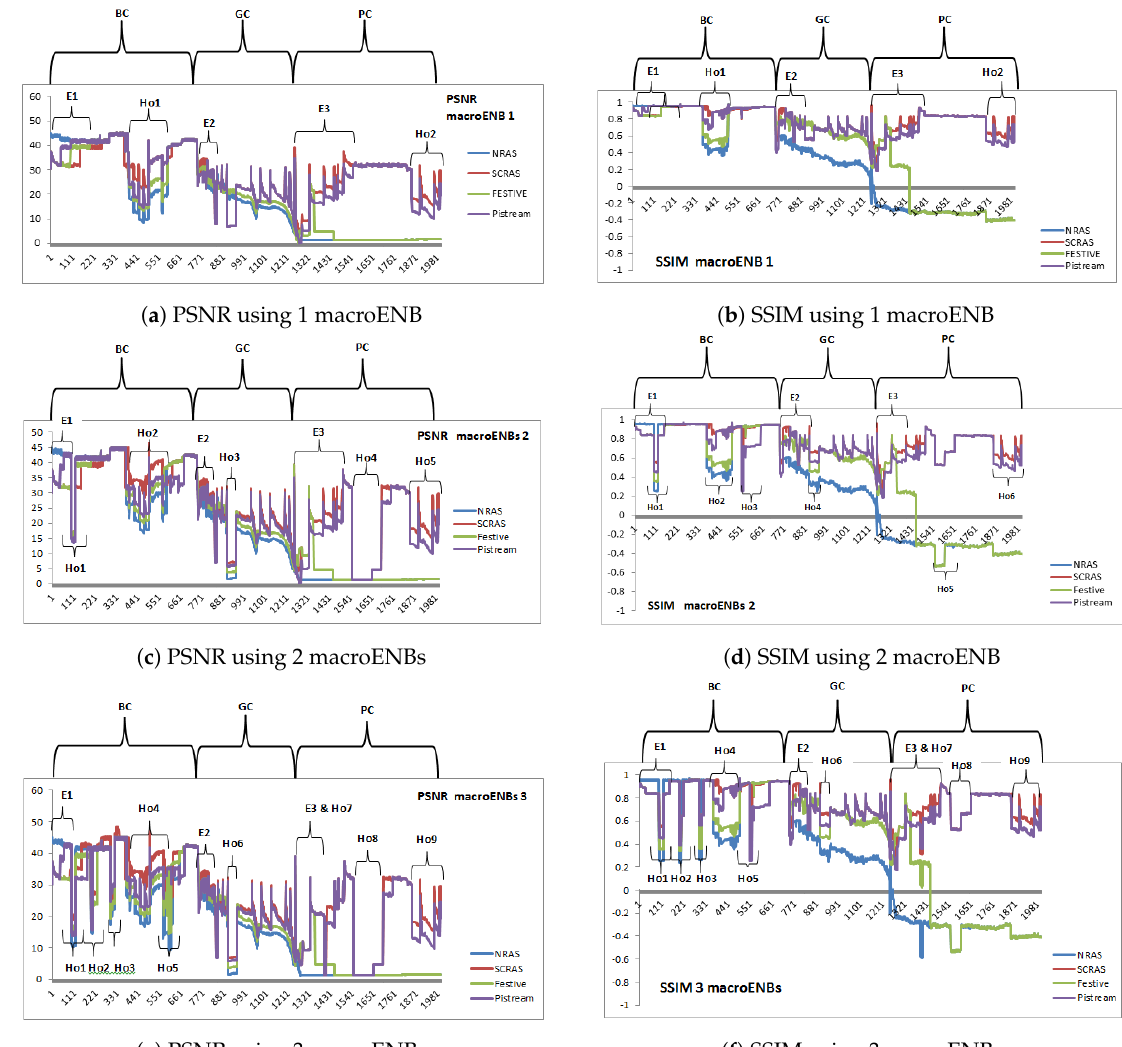
Figure 8. Impact of increasing